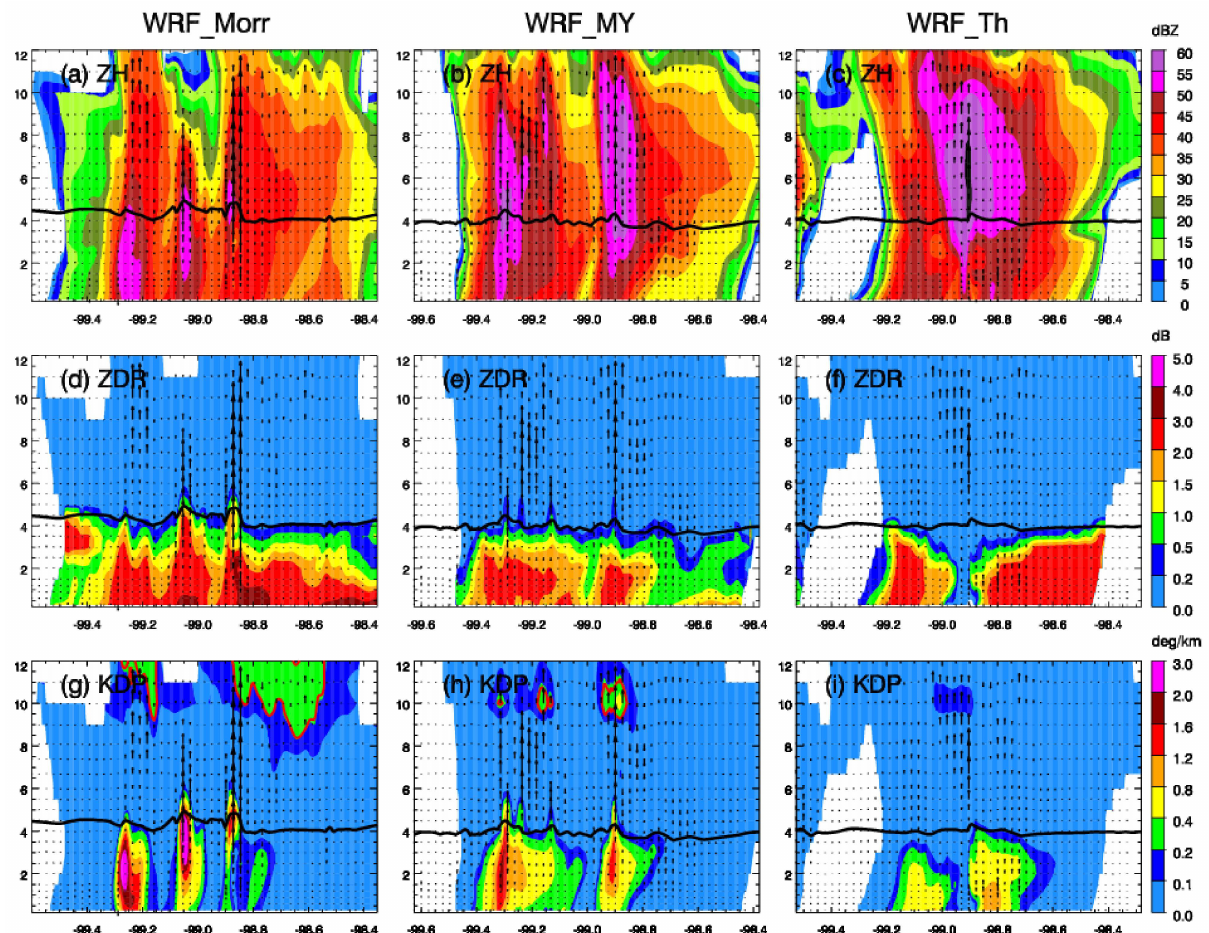
Figure 13. Vertical cross-sections of Z H in ( a – c ), Z DR in ( d – f ), and K DP in ( g – i ) for WRF_Morr, WRF_MY, and WRF_Th, respectively. Vertical cross-sections are plotted along the black lines shown in Figure 5a–c. The vectors are vertical velocity and the black curves show the height of the 0 ◦ C isotherms. The red contours in the upper level of ( g – i ) show K DP of 0.2 deg km − 1 from rain water